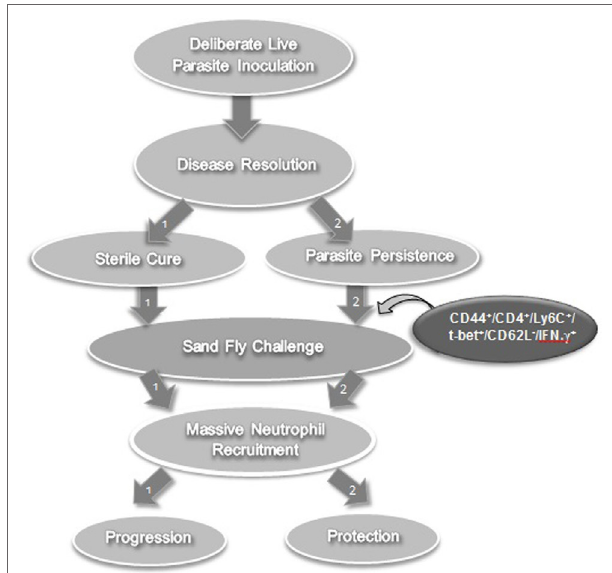
FiGURe 2 | Lessons learned from leishmanization in experimental models. Leishmanization (or deliberate parasite inoculation) fails to protect against sandfly challenge in the absence of persistent parasite (path number 1). However, if the parasite persists after healing, it gives rise to a T effector cell population that mediates effective protection against sandfly challenge (path number